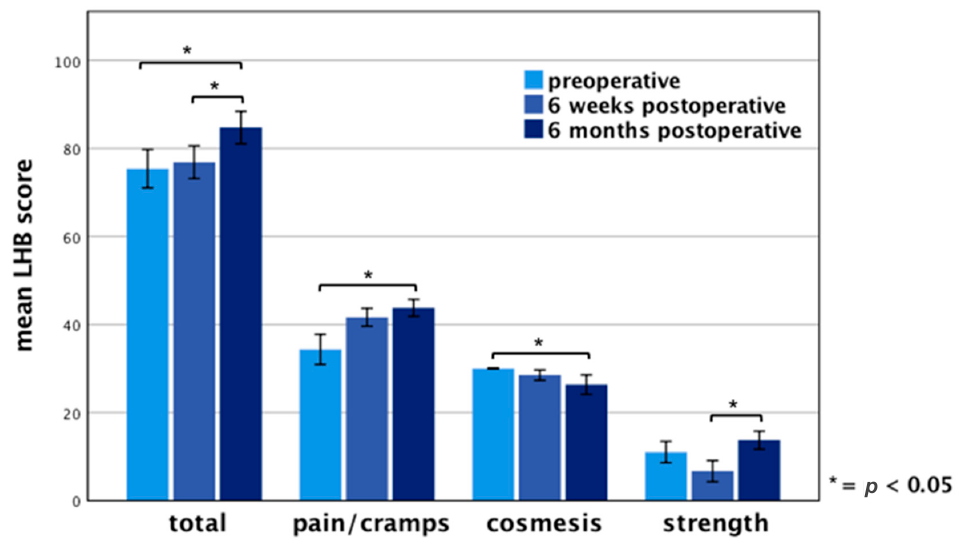
Figure 3. Results of LHB score on the operated side. Error bars indicate 95% CI. Significant differences (* p < 0.05) are designated by asterisks.